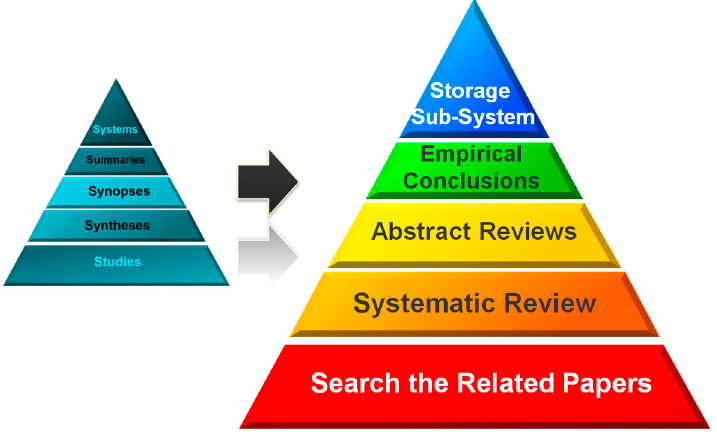
Figure 3. The 5S Pyramid Model.